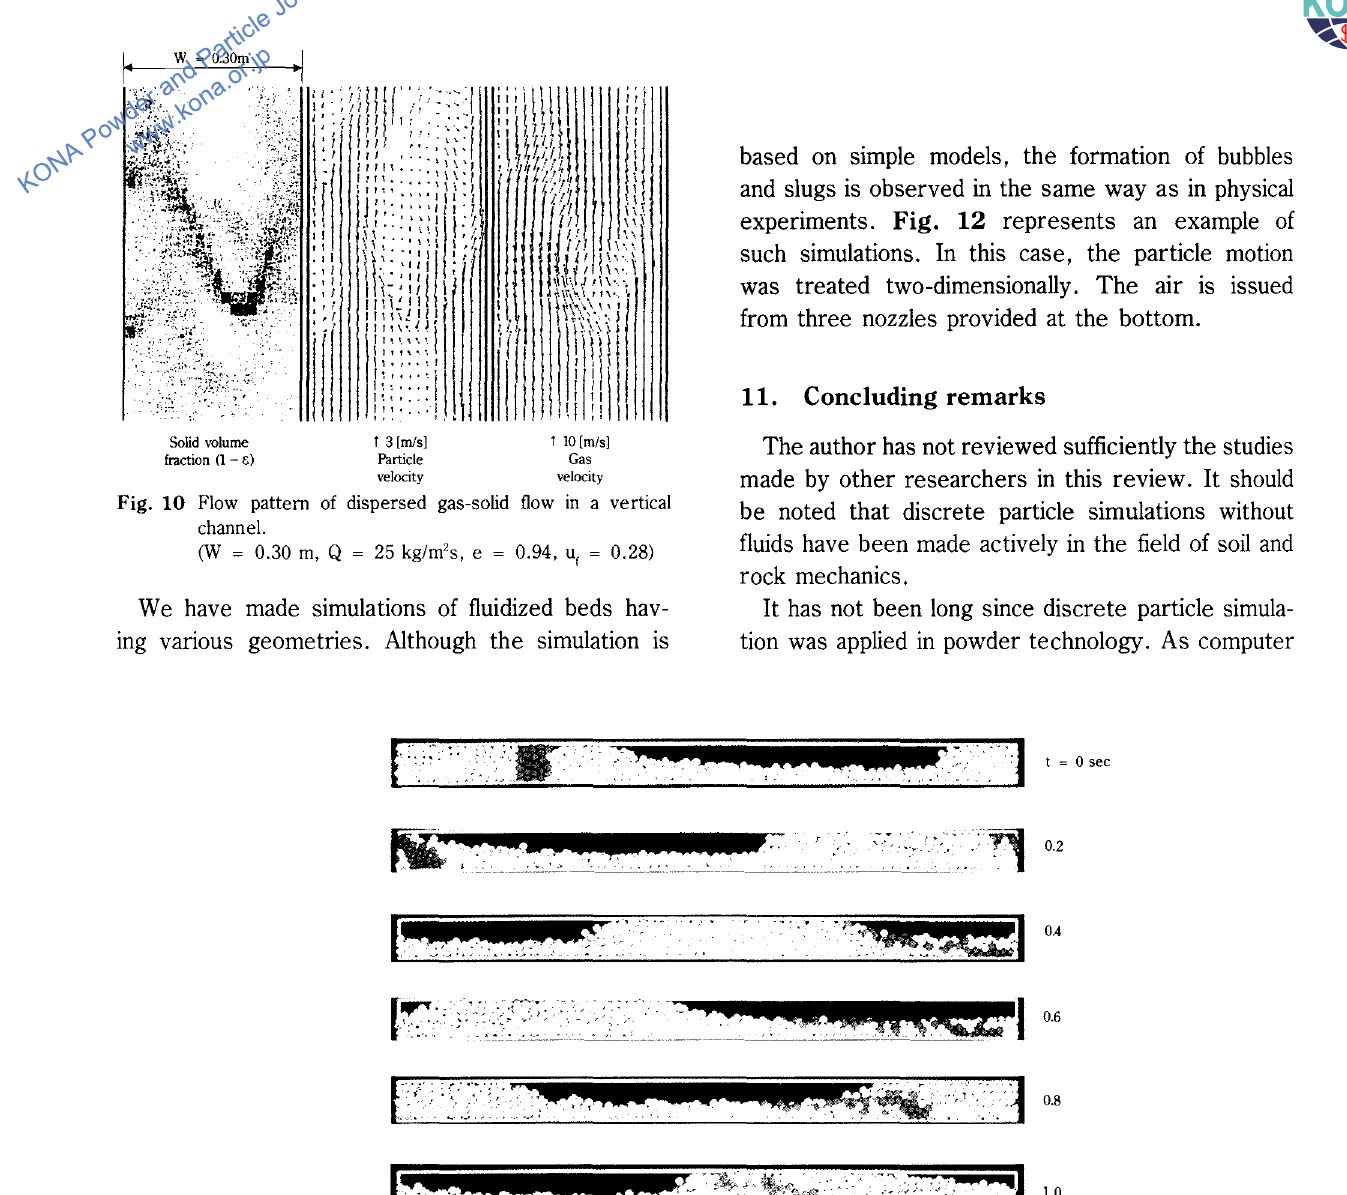
Fig. 11 Dense phase pneumatic conveying in a horizontal pipe Pipe internal diameter ; 50 mm Superficial air velocity ; 2.4 m/s